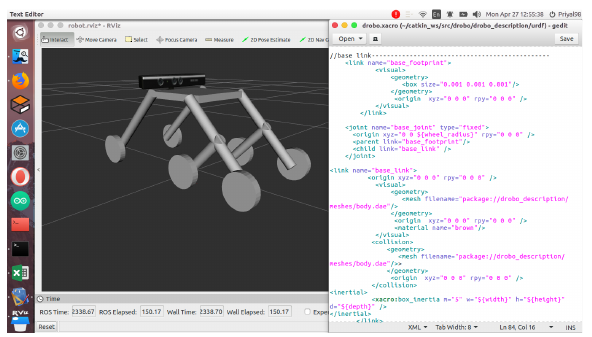
Figure 3. Rviz visualization of Drobo.